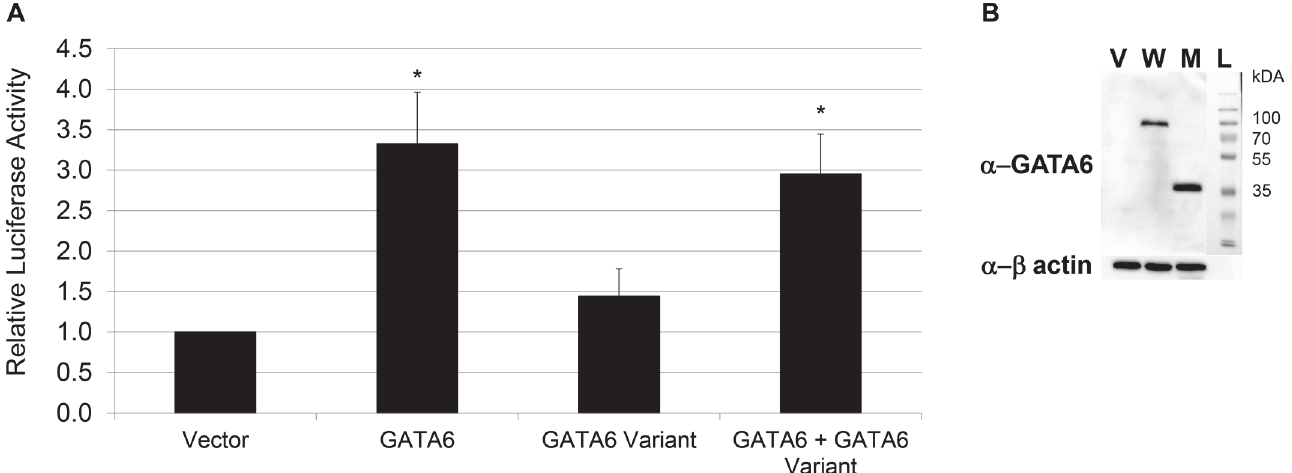
Fig 3. Loss of Hnf4 α promoter activation by GATA6 with GATA6 Y323fsX21 . A) Human wild-type GATA6 and/or GATA6 Y323fsX21 labeled ‘ GATA6 variant ’ were co-expressed with Hnf4 α promoter in INS-1 cells. Hnf4 α promoter luciferase activity was measured and levels normalized to vector alone. * P = 0.00001. B) Western blot analysis of human GATA6 protein (W lane) and GATA6 Y323fsX21 (M lane) expressed in HEK 293T cells. Vector (V lane) only was a negative control and to approximate the size a protein ladder (L lane) was utilized. GATA6 was detected with a GATA6 antibody against the N-terminal of the protein and beta actin was measured as a loading